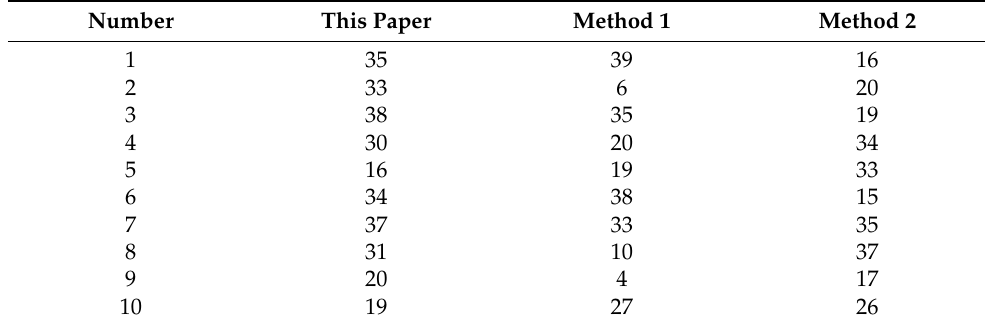
Table 4. Sorting of core nodes selected by three